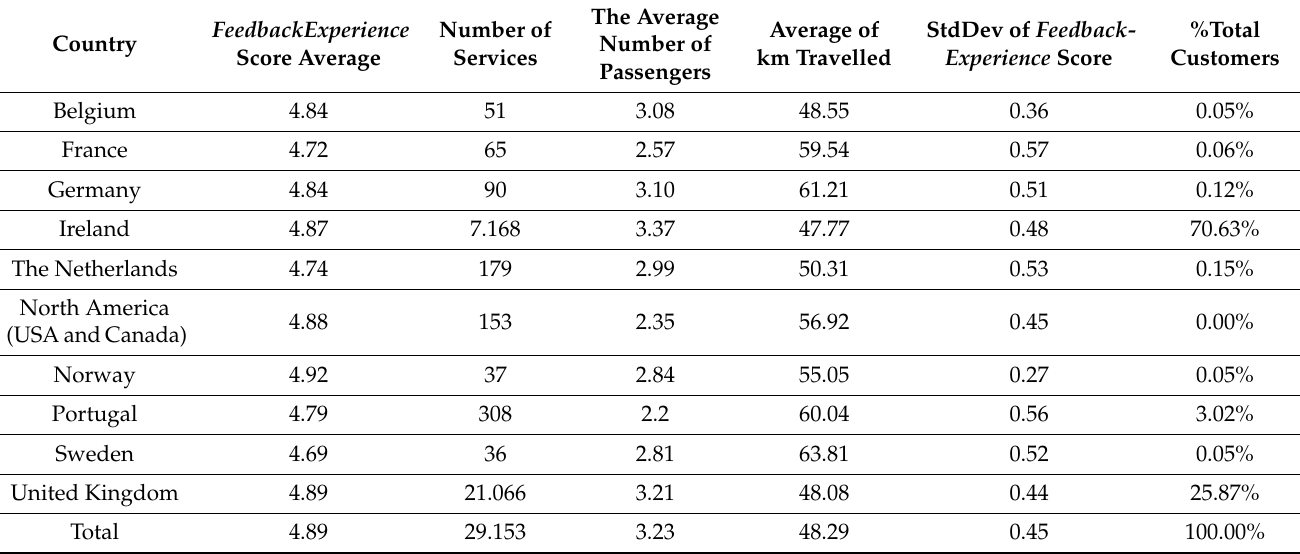
Table 4. Characterisation of the top ten countries in the number of